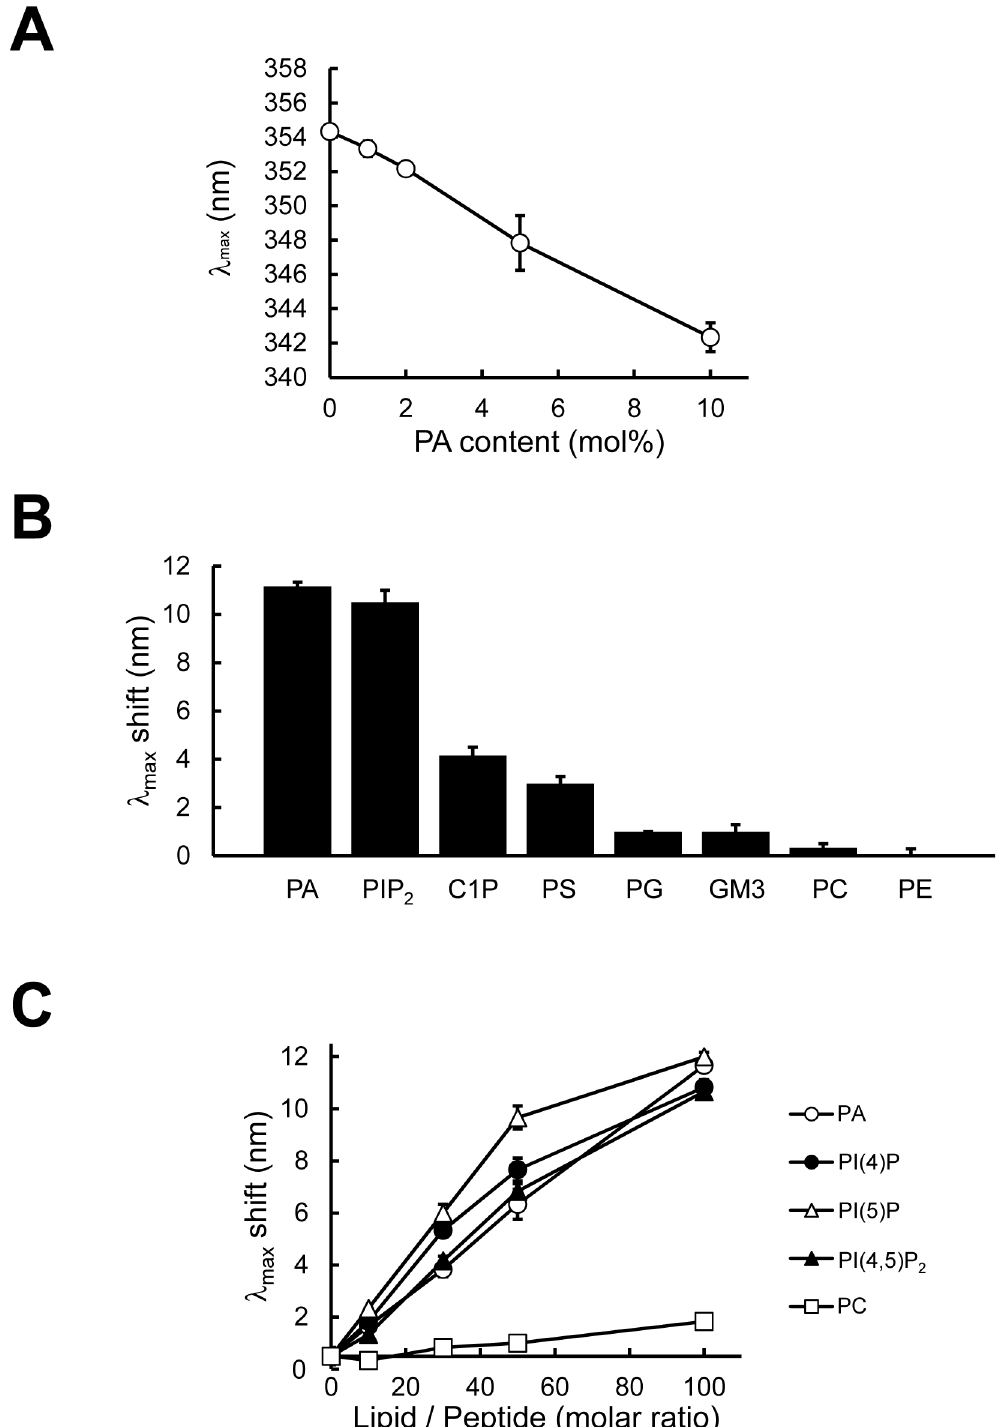
Fig 7. Analysis of PAB-TP by fluorescence measurement of tryptophan residues. (A) PAB-TP was incubated with LUVs (160 μ M total lipids) composed of DOPA/DOPC/cholesterol (10:60:30), (5:65:30), (2:68:30), (1:69:30), and (0:70:30) for 1h at 25°C. Fluorescence spectra were obtained with the excitation wavelength at 280 nm and the wavelength of maximum fluorescence ( λ max ) was plotted against PA content (mol%). (mean ± SE, n = 3). (B) PAB-TP was incubated with LUVs (160 μ M total lipids) composed of DOPC, cholesterol, and indicated lipids (60:30:10) for 1h at 25°C. Fluorescence spectra were obtained with the excitation wavelength at 280 nm and blue shift in the wavelength of maximum fluorescence ( λ max ) was calculated. (mean ± SE, n = 3). (C) PAB-TP was incubated with LUVs (0 – 160 μ M total lipids) composed of DOPC, cholesterol, and indicated phospholipid (60:30:10) for 1h at 25°C.